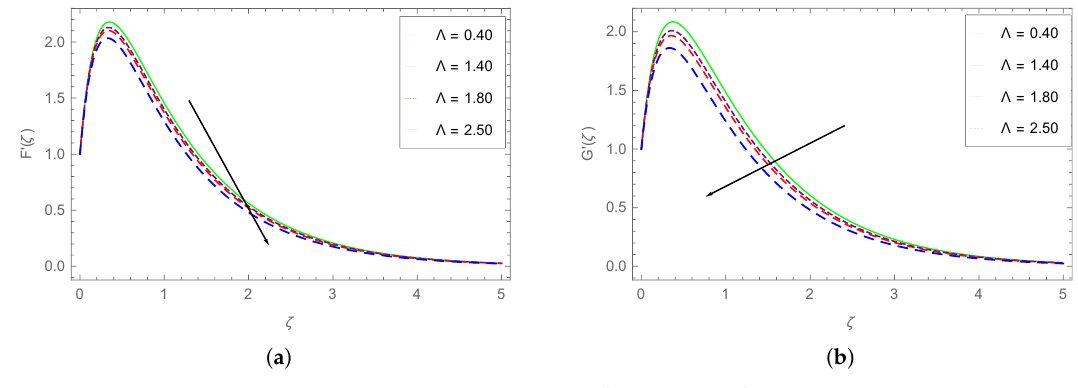
Figure 8. Impact of Λ on ( a ) F (cid:48) ( ζ ) and ( b ) G (cid:48) ( ζ ) .